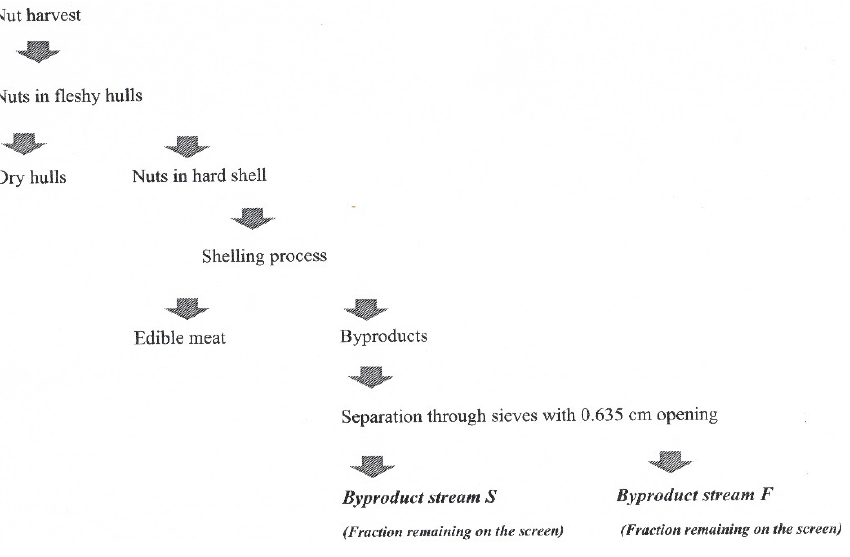
Figure 1. Pecan nut processing flow chart.